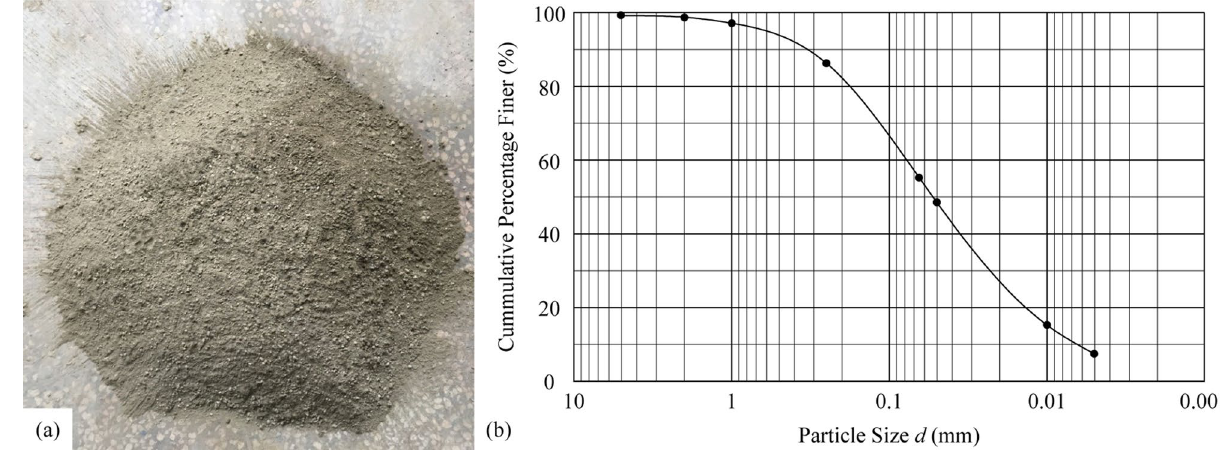
Figure 4. ( a ) Soil material used in the scouring experiment; ( b ) grading curve of the soil material.